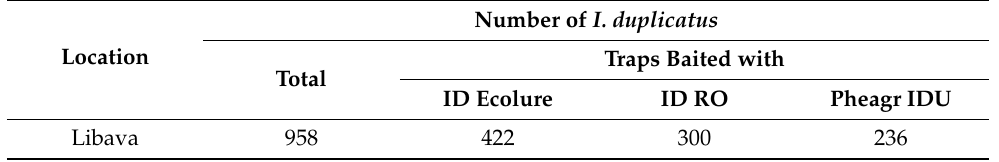
Table 4. Ips duplicatus beetles caught in the field in 2017